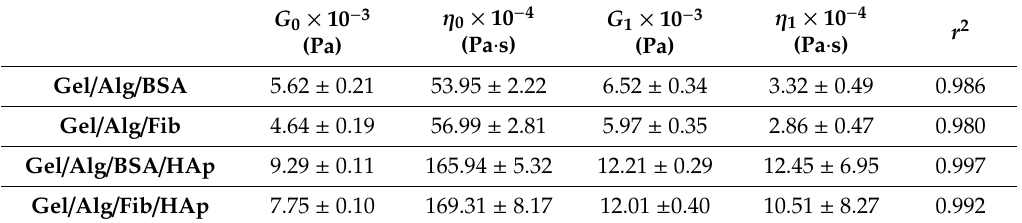
Table 2. Values of the Burger model parameters. Results from the fits by Equation (6).